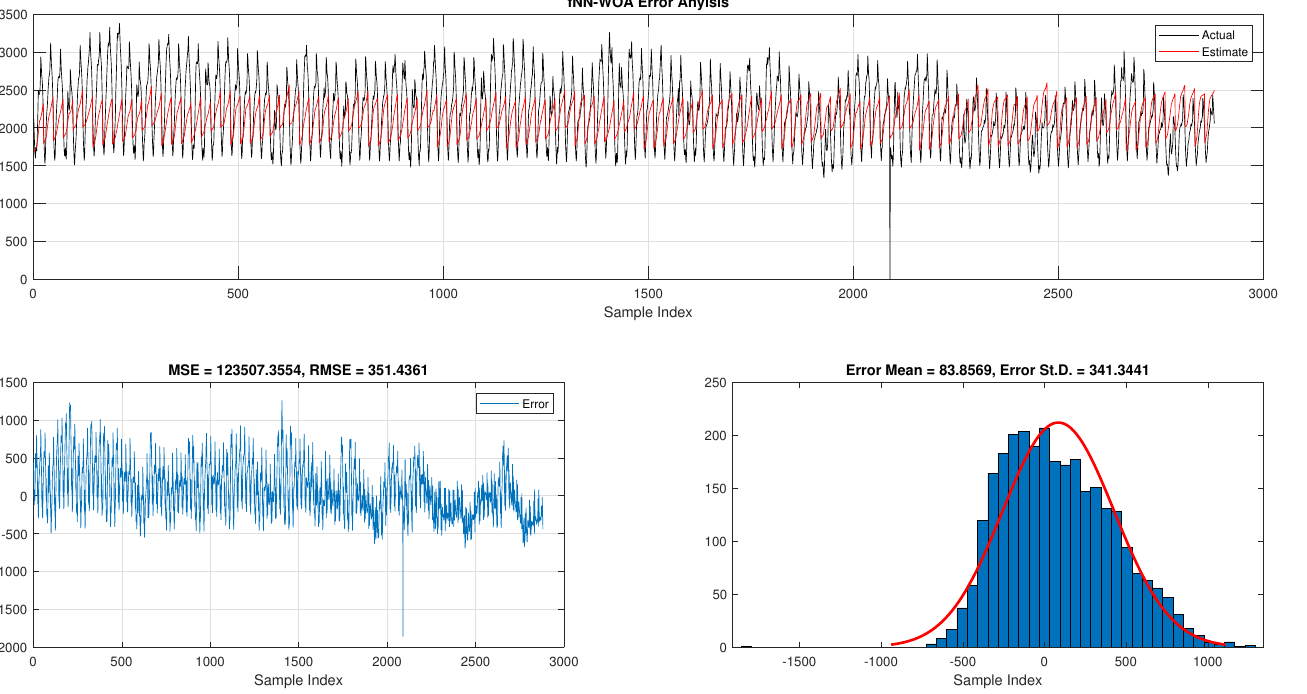
Figure 14. Error analysis of the hourly daily load consumption with fNN-WOA best results. The results of the total daily load consumption are portrayed in Table 6. Like previous experiments, the fNN-GWO exceeds the other meta-heuristic algorithms with all measures, followed by, fNN-GA, fNN-PSO, fNN-ACO, fNN-ES, and fNN-WOA. The difference between fNN-GWO and the closet one (fNN-GA) for MSE, ED, MAE, and RMSE